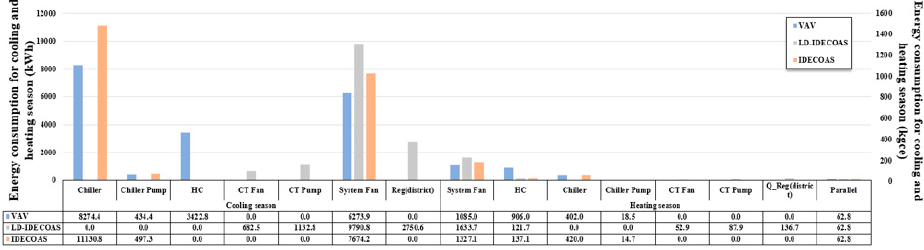
Figure 17. The seasonal energy consumption comparison in Guangzhou.